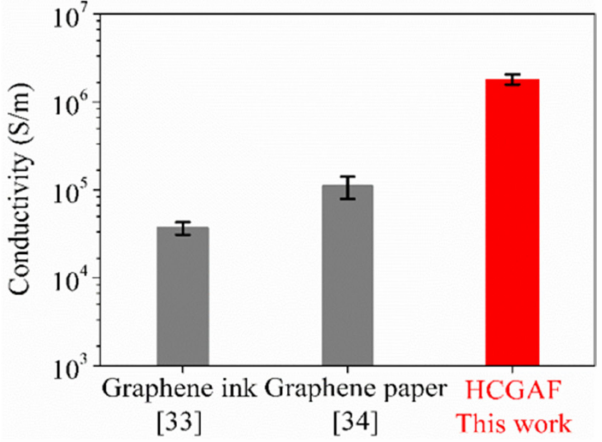
Figure 5. Conductivity comparison of three